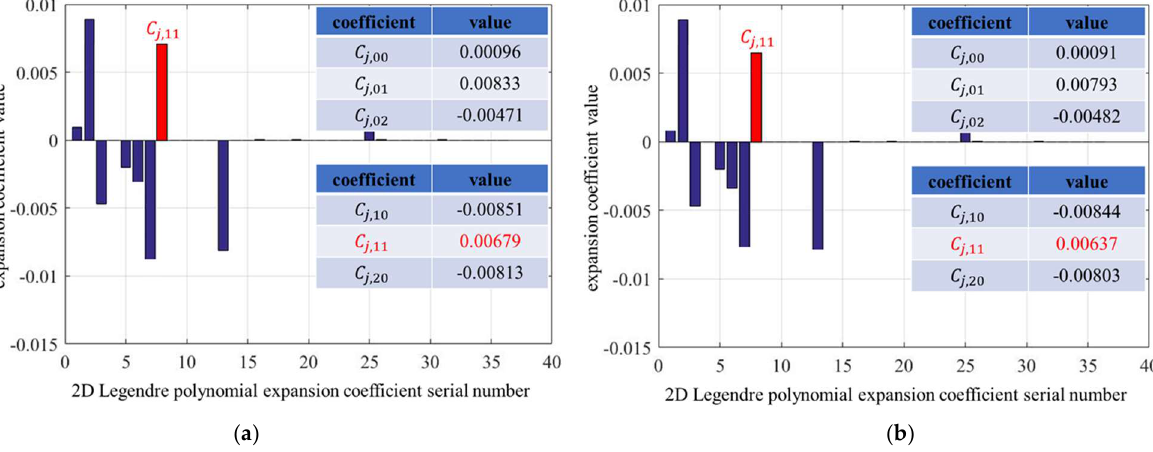
Figure 9. 2-D Legendre coefficients of the measurement. ( a ) 2-D Legendre coefficients of the left flank . ( b ) 2-D Legendre coefficients of the right flank .